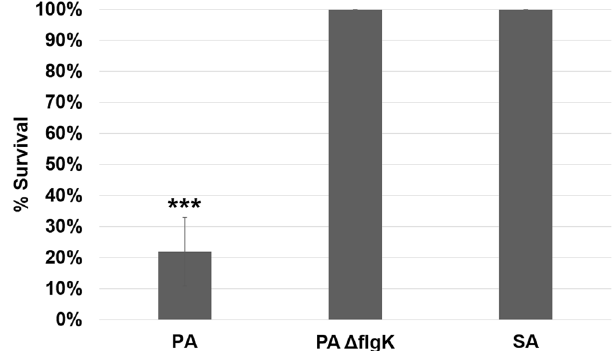
Figure 2. Swimming motility is required for dispersal-induced septicemia. Treatment of 48-hour mouse chronic wounds, infected with wild-type (PA) or a flagella mutant of P. aeruginosa , or with S. aureus (SA), with 10% α -amylase and cellulase (1:1; GH), resulted in ~80% septicemia only in mice infected with the motile strain. Repeated measures ANOVA and the Tukey-Kramer multiple-comparison test were used to test for differences between columns: *** p < 0.001. N = 9 for each group.